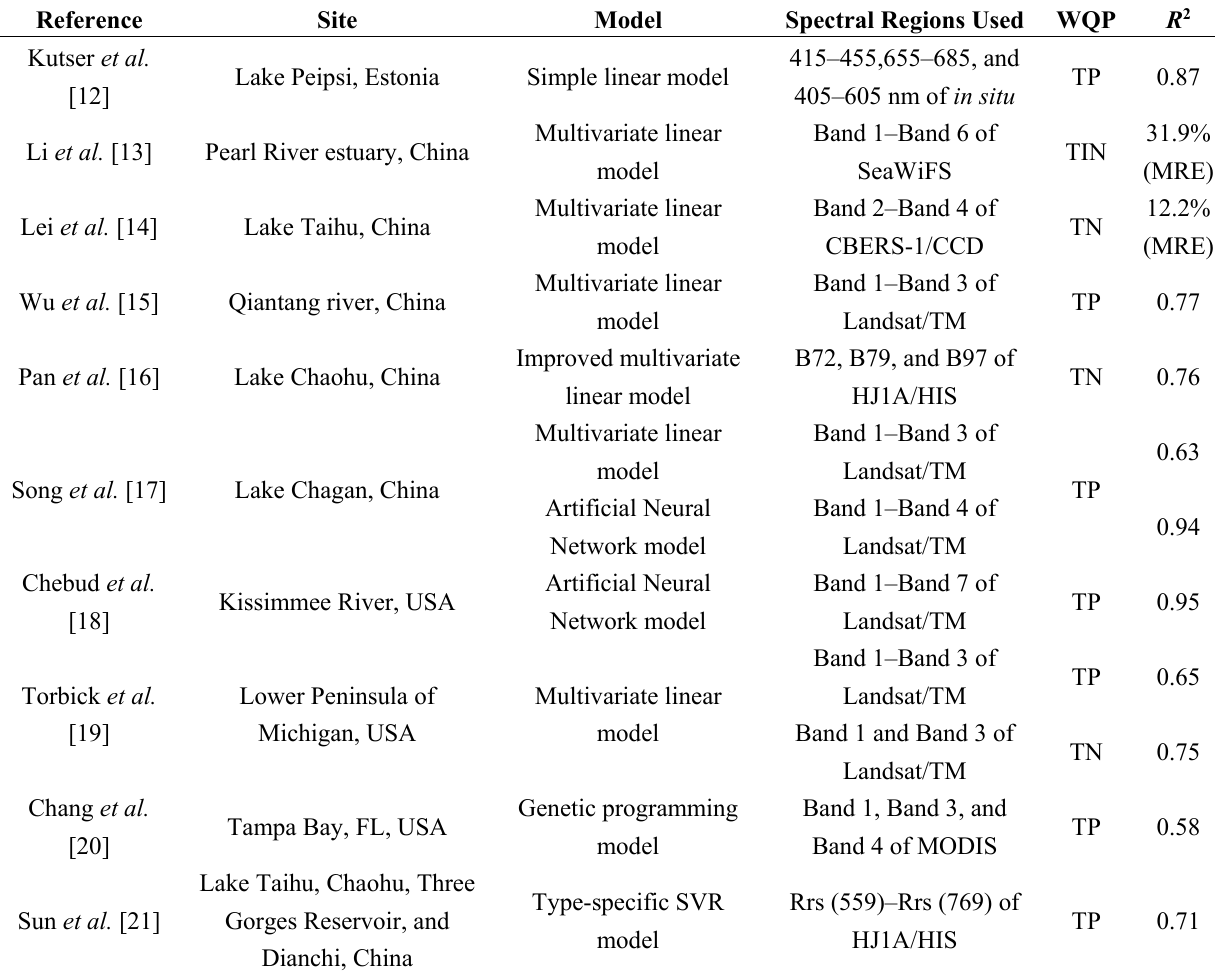
Table 1. Previous studies on retrieving TN and TP concentrations of water